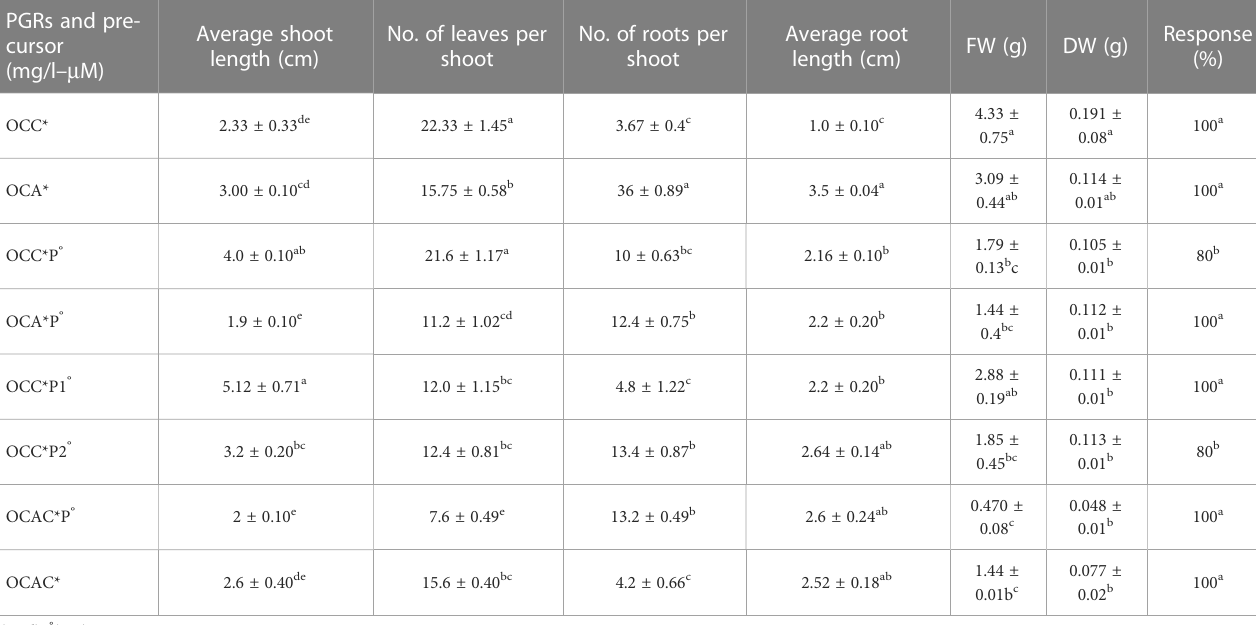
TABLE 4 Effect of optimal concentrations and combinations of PGRs and precursor on regeneration of Bacopa fl oribunda . PGRs and pre-